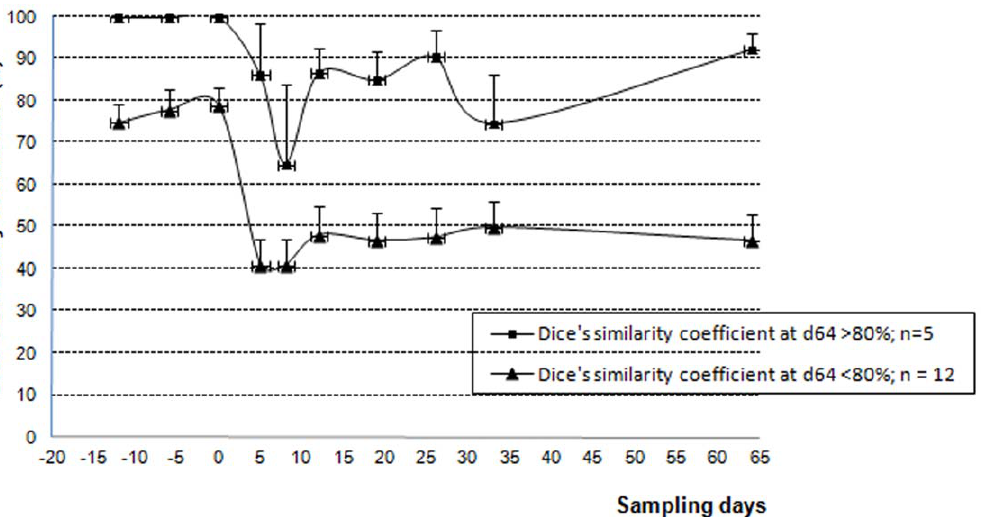
Figure 5. Mean similarity coefficients of specific Bifidobacterium TTGE profiles of samples collected before and after AMC exposure (day0–day5) and calculated according to the reference period (day-12 day-6 day 0; n=17).